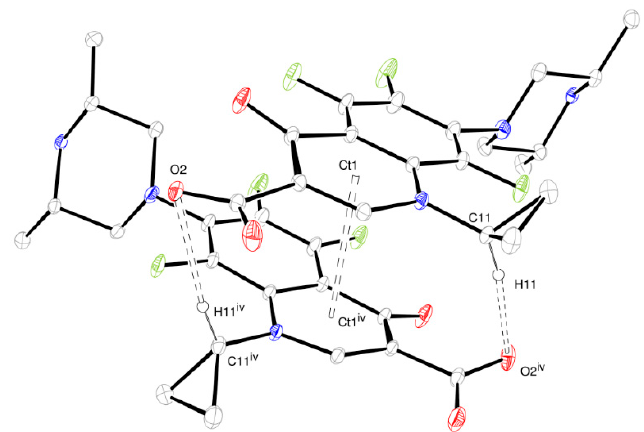
Figure 6. ORTEP-3 view of the inter-layer intermolecular contacts stabilized by non-classical hydrogen bonds and π -aryl- π -aryl interactions (dashed line). Ct is the aromatic ring calculated centroid. The hydrogen atoms not involved in the depicted hydrogen bonds were omitted for clarity. Symmetry code: iv − x, y, − z + 3/2.